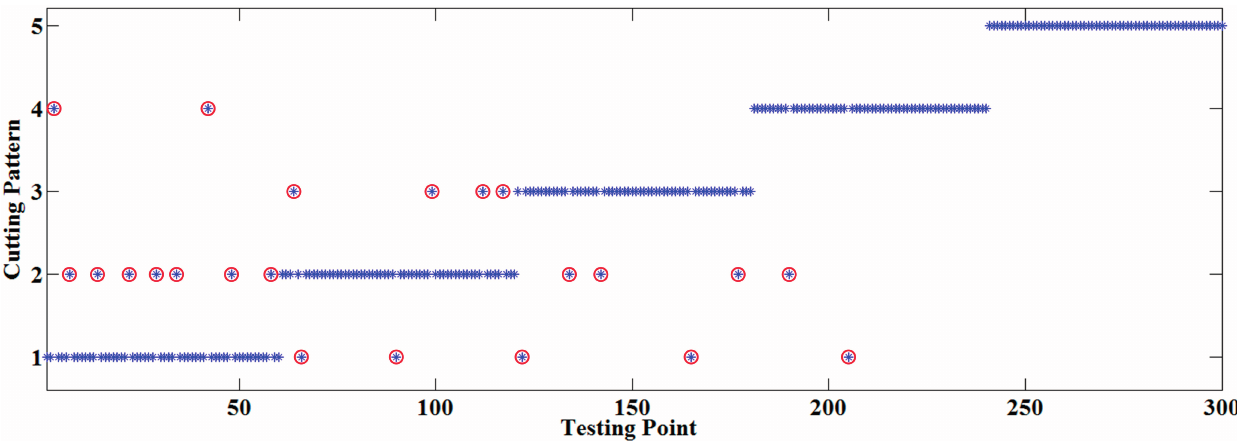
Figure 6. Comparison between actual pattern and PNN prediction result.